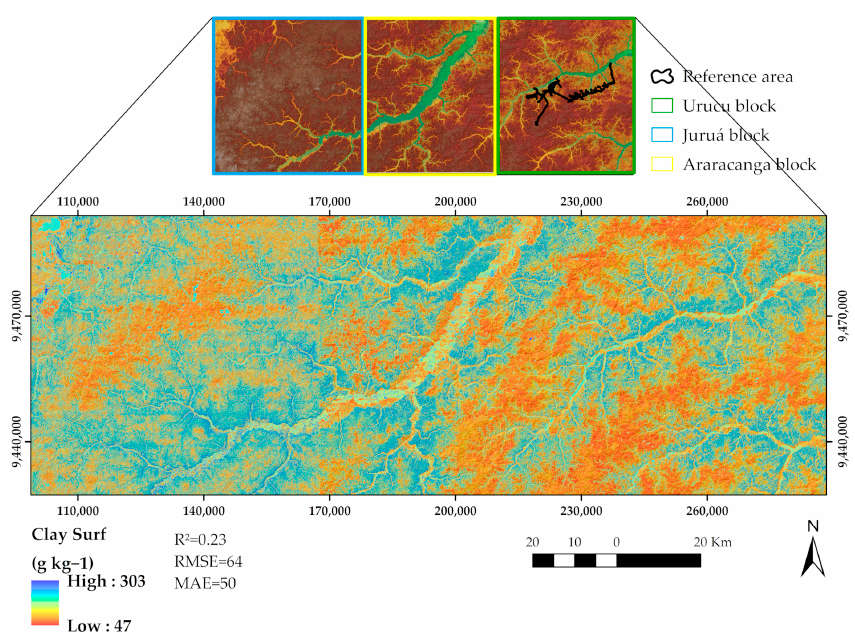
Figure 13. Map of the clay content at the surface layer. (Map generated using the Total Area sampling design, Random Forest, and Previous Covariate Selection).